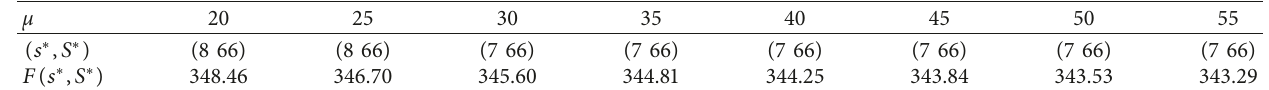
Table 4: The effect of the parameter μ on the optimal policy and the optimal cost.